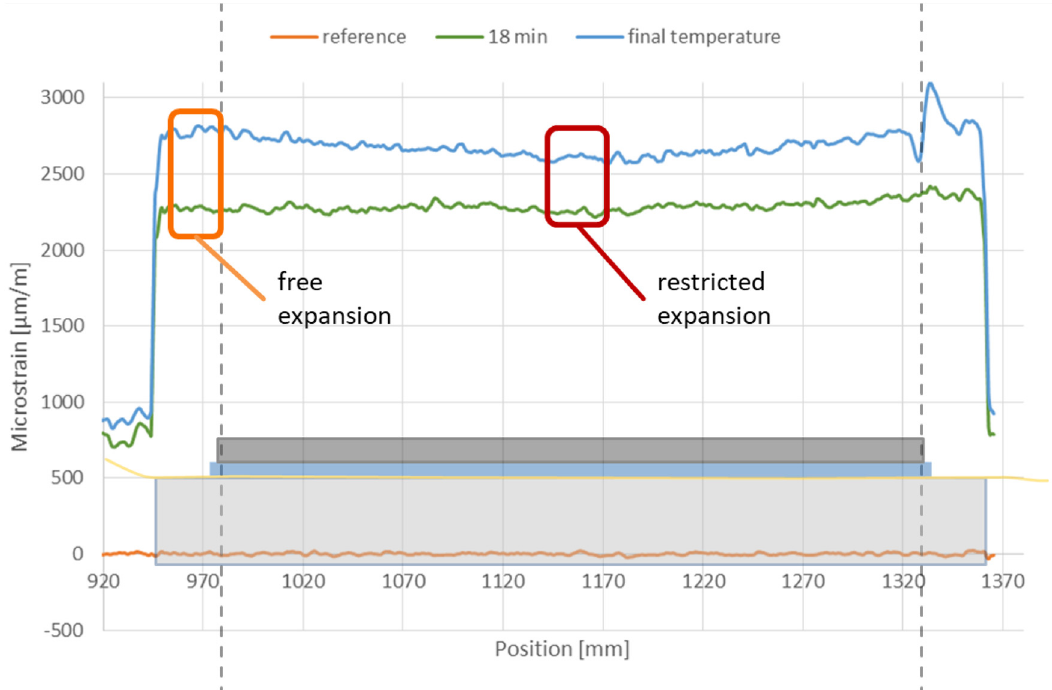
Fig. 7. Deformation during the heating phase.